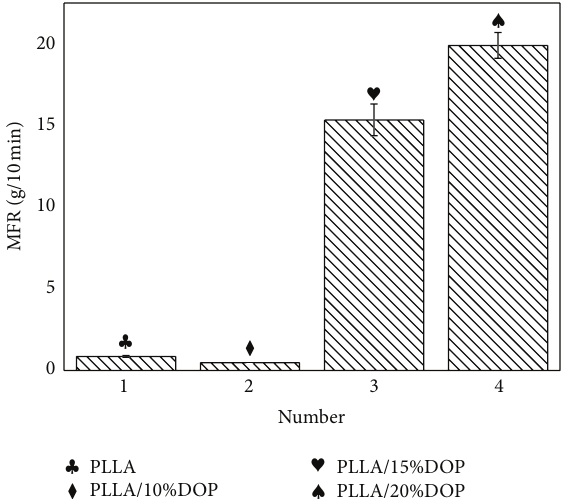
Figure 6: The effect of DOP content on MFR of PLLA. influence of DOP on the mechanical performance of PLLA.